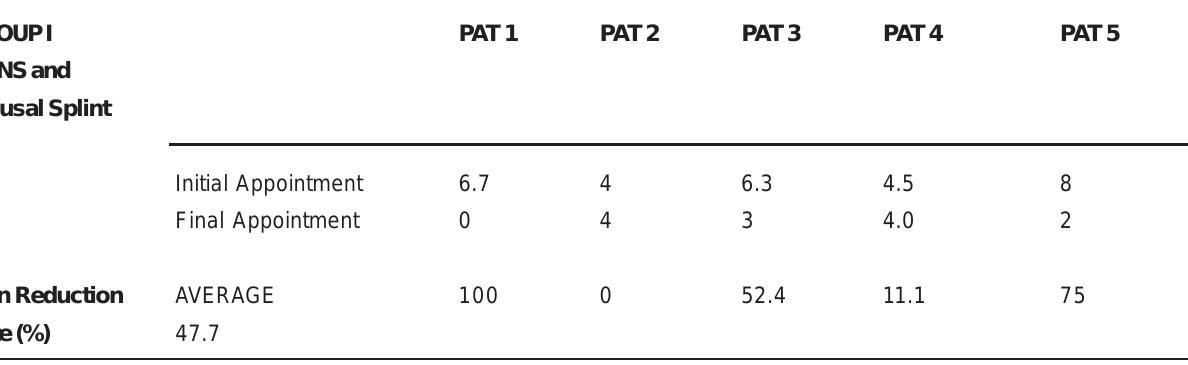
TABLE 1- Pain level of patients before and after treatment in group I (MENS and Occlusal Splint) using a Visual Analogue Scale